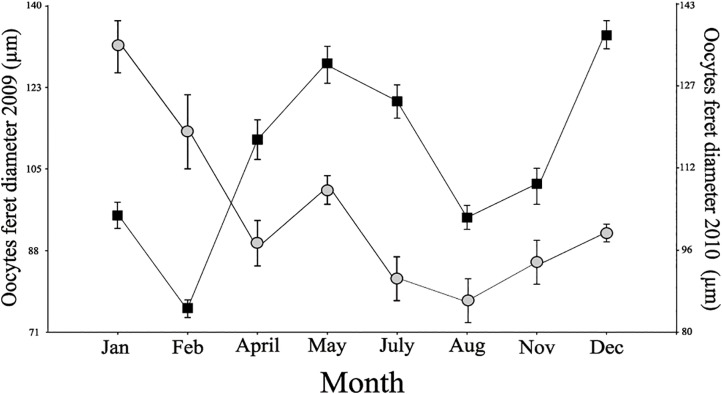
Oocytes feret diameter.Mean oocyte feret diameter (μm) in 2009 (black box) and mean oocyte feret diameter in 2010 (gray circle). Vertical bars indicate ± SE.